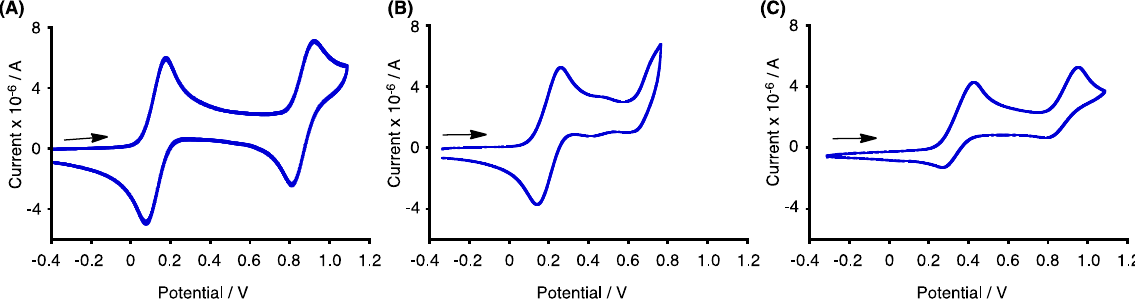
Figure 3. Cyclic voltammograms of ( A ) 1b , ( B ) 2b , and ( C ) 3b (Pt electrode, 0.1 M Bu 4 NClO 4 in CH 2 Cl 2 , vs. Fc/Fc + ).